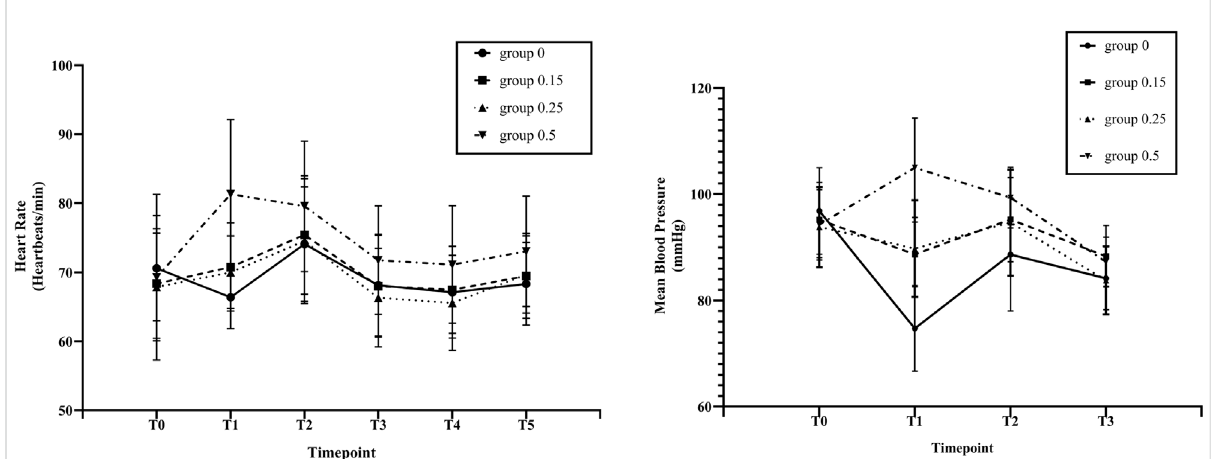
FIGURE 3 Changes in heart rate (HR) and mean blood pressure (MBP) by study groups across different study time points. Before induction of anesthesia (T0; baseline), at the end of anaesthesiainduction (T1), at the time of endoscope insertion (T2), at the end of endoscopy (T3), at arrived at PACU (T4) and at patients ’ awakening (T5). Group 0, esketamine 0 mg/kg group;Group 0.15, esketamine 0.15 mg/kg group; Group 0.25, esketamine 0.25 mg/kg group; Group 0.5, esketamine 0.5 mg/kg group. Data are presented as means and vertical bars denote standard deviation.